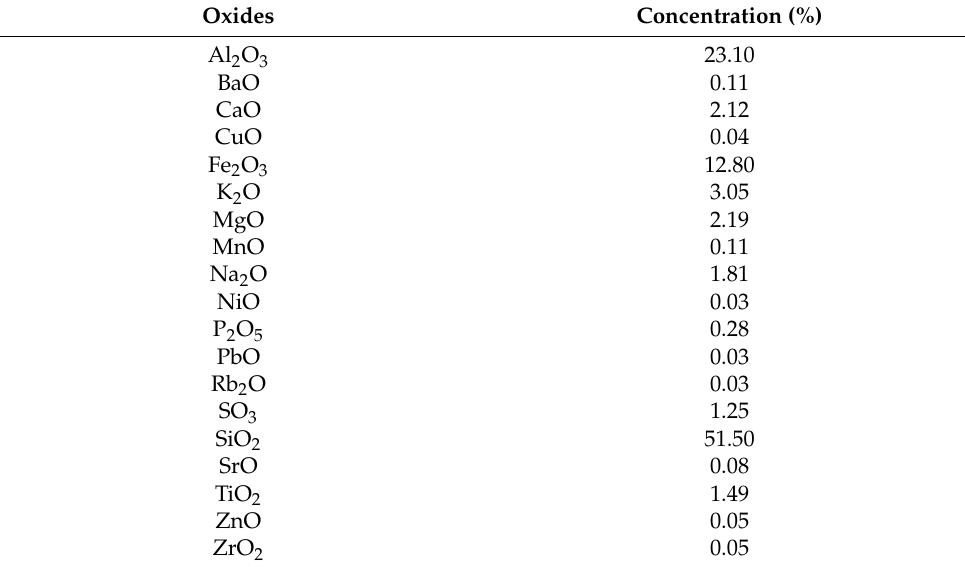
Figure 7. Microstructure of the fly ash obtained by SEM. Table 2. Chemical composition of the fly ash obtained by XRF.